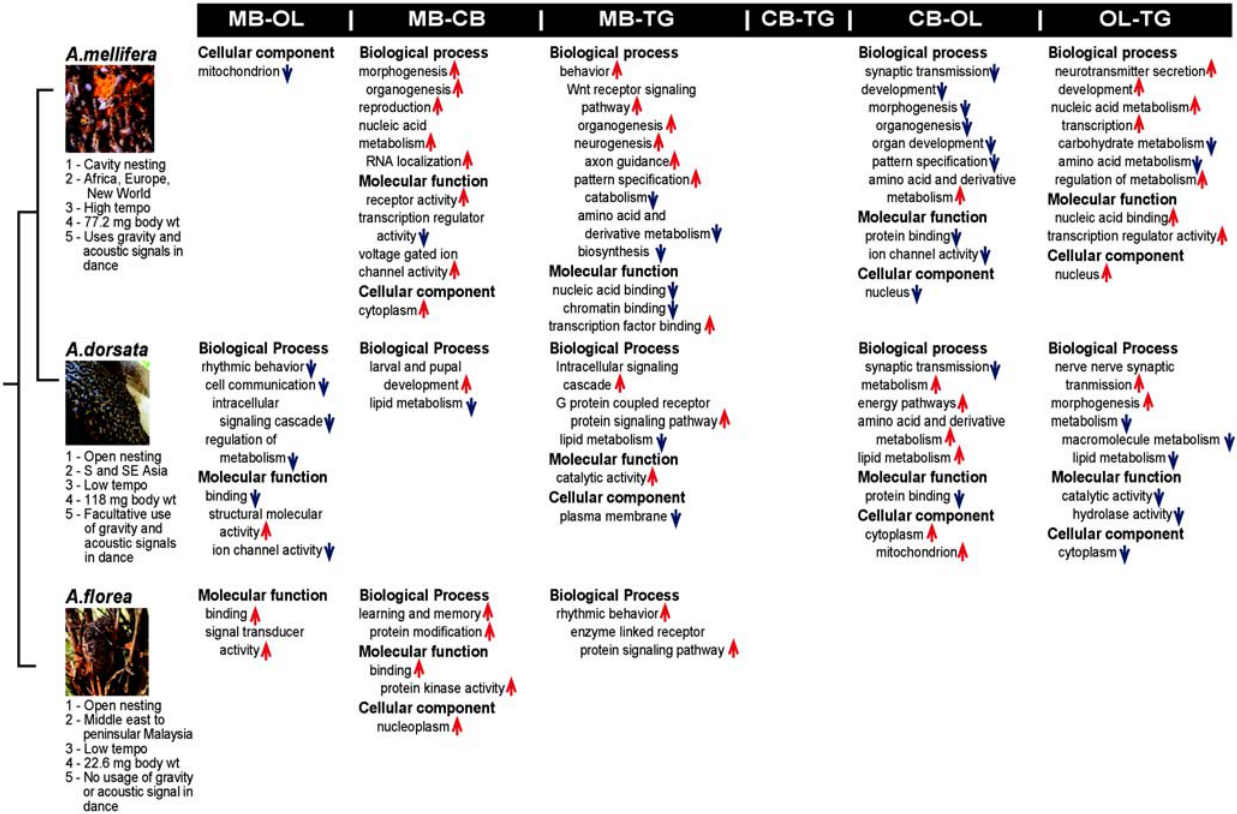
Figure 4. Results of GO enrichment analysis of genes that showed species by CNS region differences in gene expression, based on pair-wise comparisons of the CNS regions (p , 0.01, Chi-Square test with Yates continuity correction). First column shows the species with relevant differences in behavior and ecology with phylogenetic ranking after [68,69]. Upward arrows indicate upregulation of enriched genes of a given GO class in the first brain region of the pair, while downward arrows indicate upregulation of enriched genes of a given GO class in the second brain region of the pair. Abbreviations as in Table 1.